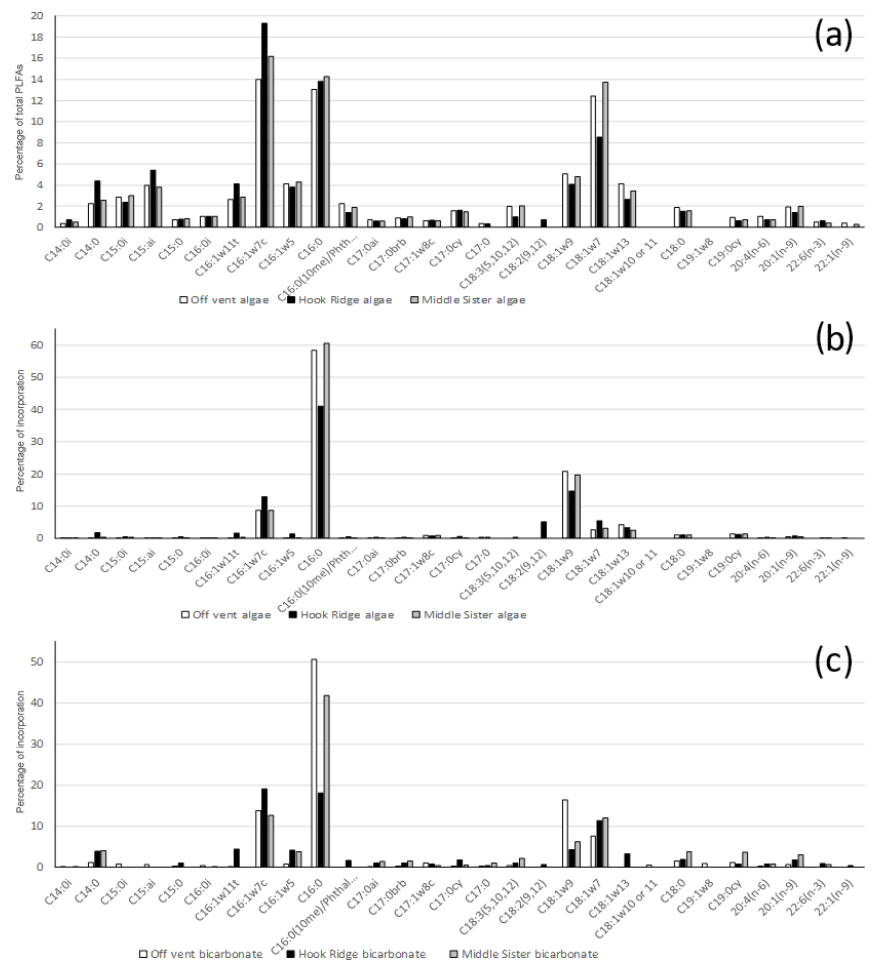
Figure 4. Example PLFA suites – each data series is from one sample, as opposed to being an average across two replicates. (a) PLFA suite as percentage of the total PLFAs in the algae addition experiments (figure for bicarbonate addition experiments very similar and not shown). (b) The composition of 13 C uptake into PLFAs in algae addition experiments. (c) The composition of 13 C uptake into PLFAs in bicarbonate addition